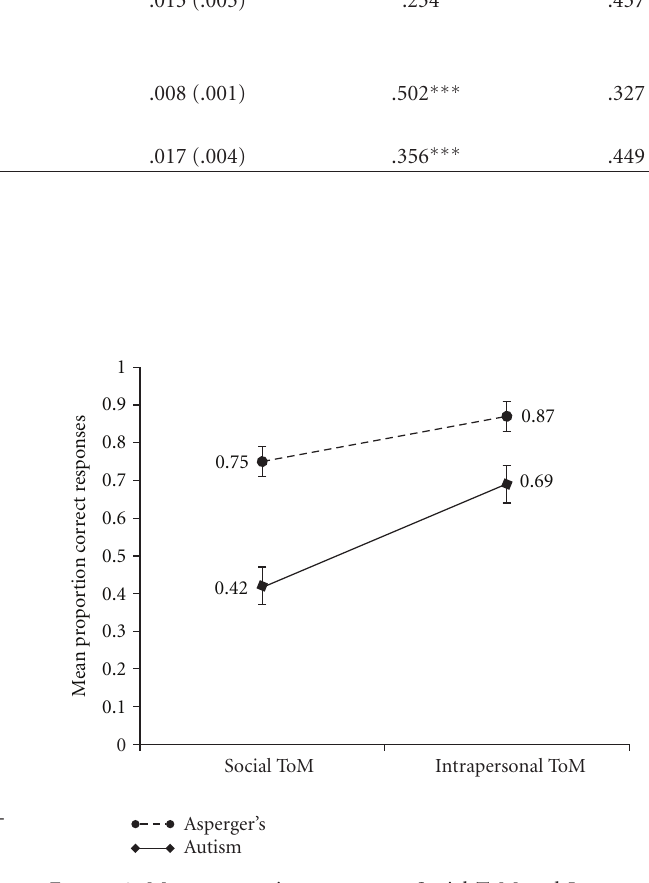
Figure 2: Mean proportion correct on Social ToM and Intraper- sonal ToM for children with autism and Asperger